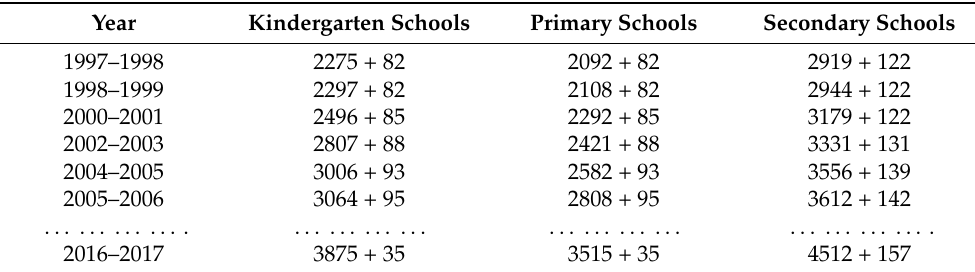
Table A3. Public subsidy per student paid to Qu é bec’s independent schools by schooling level, selected years, in Canadian dollars.